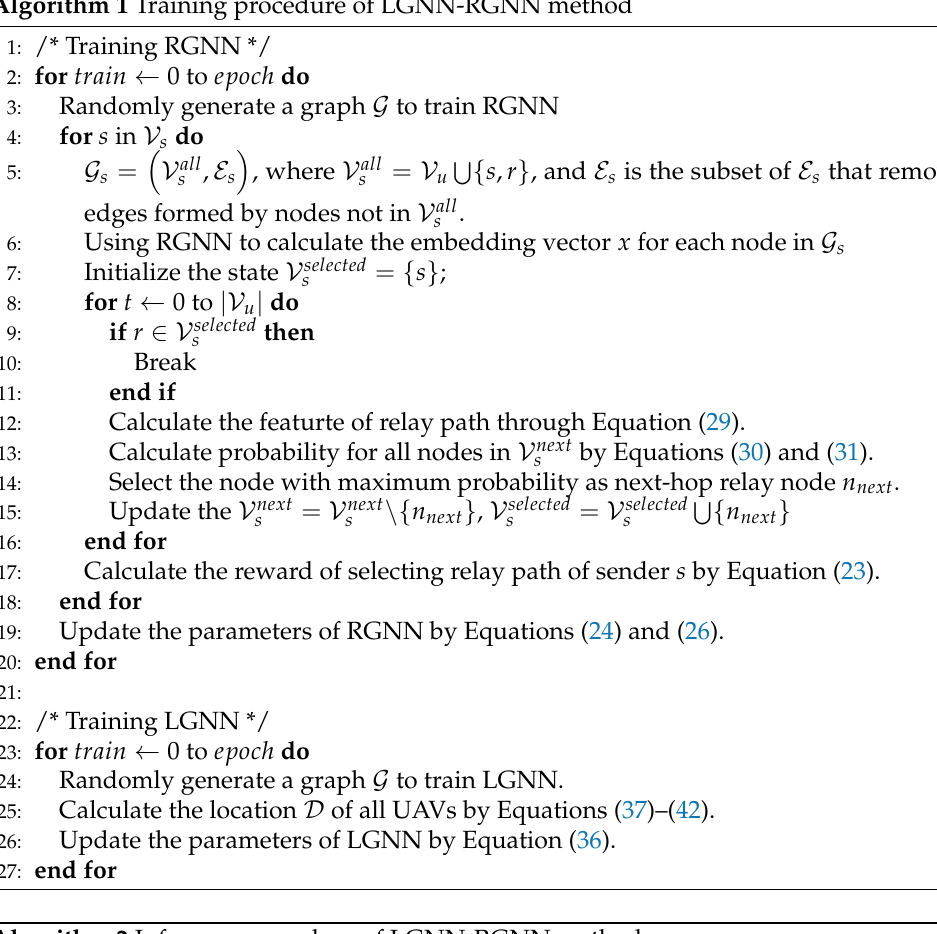
Algorithm 2 Inference procedure of LGNN-RGNN